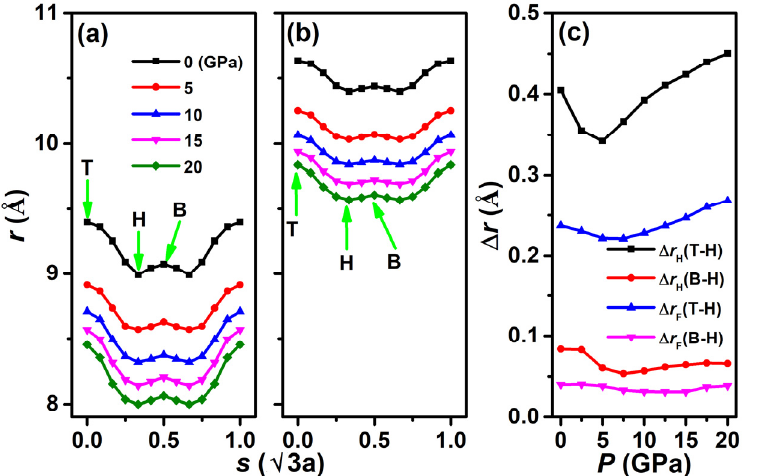
√ 3 times of lattice